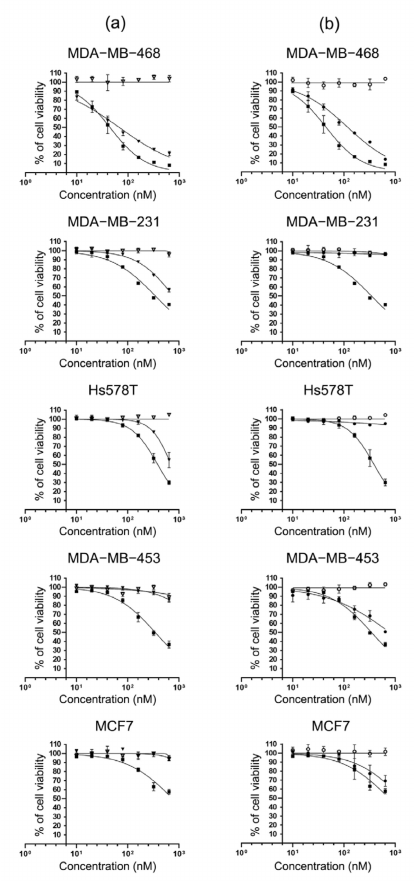
Figure 3. Specific cytotoxicity of MMAE conjugated scFv-SNAP fusion proteins. TNBC cell lines (MDA-MB-468, MDA-MB-231, Hs578T and MDA-MB-453) and ER + cell line MCF7 were incubated with increasing concentrations (0, 10, 20, 40, 80, 160, 320, 640 nM) of MMAE, scFv-SNAP fusion proteins and corresponding ADCs at 37 ◦ C for 72 h. ( a ) Cells treated with scFv-425-SNAP ( (cid:53) ), scFv-425-SNAP-MMAE ( (cid:72) ) and MMAE ( (cid:4) ). ( b ) Cells treated with scFv-EpCAM-SNAP ( (cid:13) ), scFv- EpCAM-SNAP-MMAE ( • ) and MMAE ( (cid:4) ). Cytotoxicity was evaluated by cell viability assay. The experiment was carried out in triplicates at least three times. Data are shown as mean ± SD of one independent